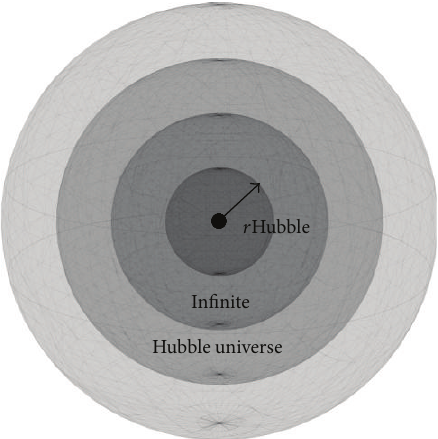
Figure 9: Infinitely mass filled expanding Hubble